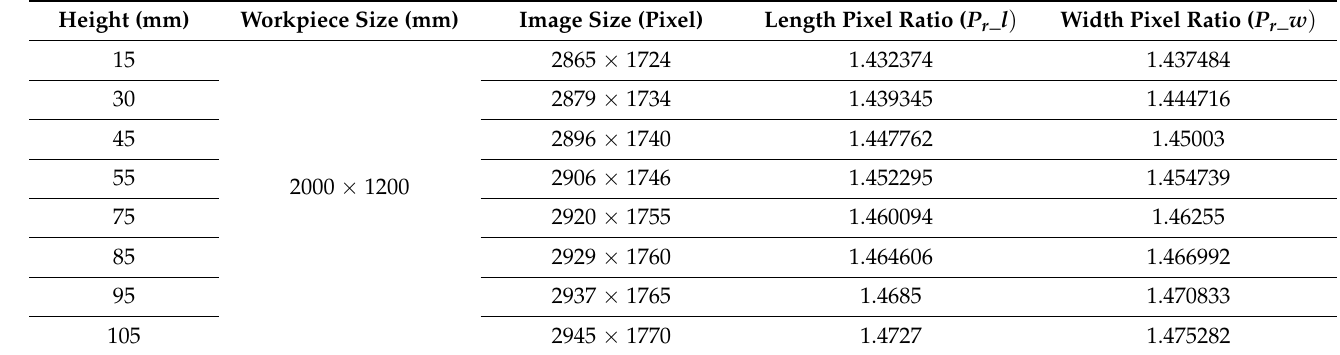
Table 6. Length and width pixel ratio at different